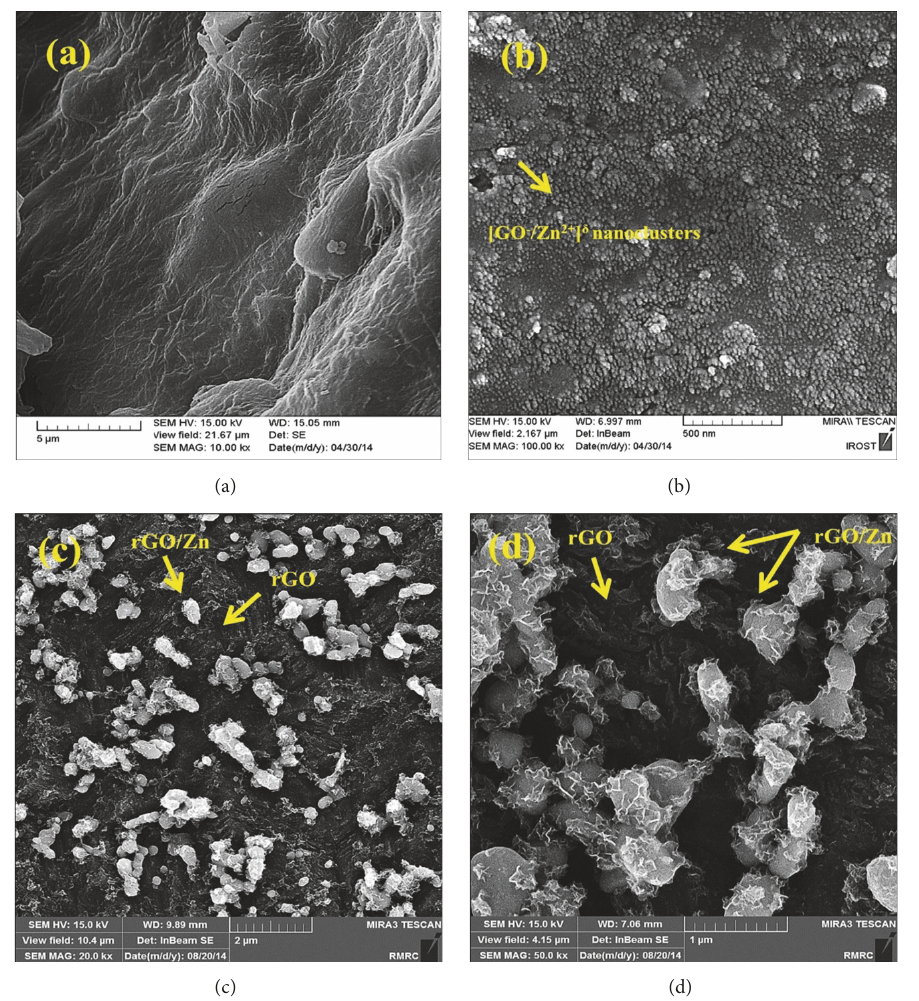
Figure 8: FE-SEM images of (a) synthesized GO nanosheets; (b) [GO − /Zn 2+ ] 𝛿+ nanoclusters distributed on GO nanosheets (before pulse- potential electrodeposition); (c) and (d) rGO-Zn coating synthesized by pulse-potential electrodeposition